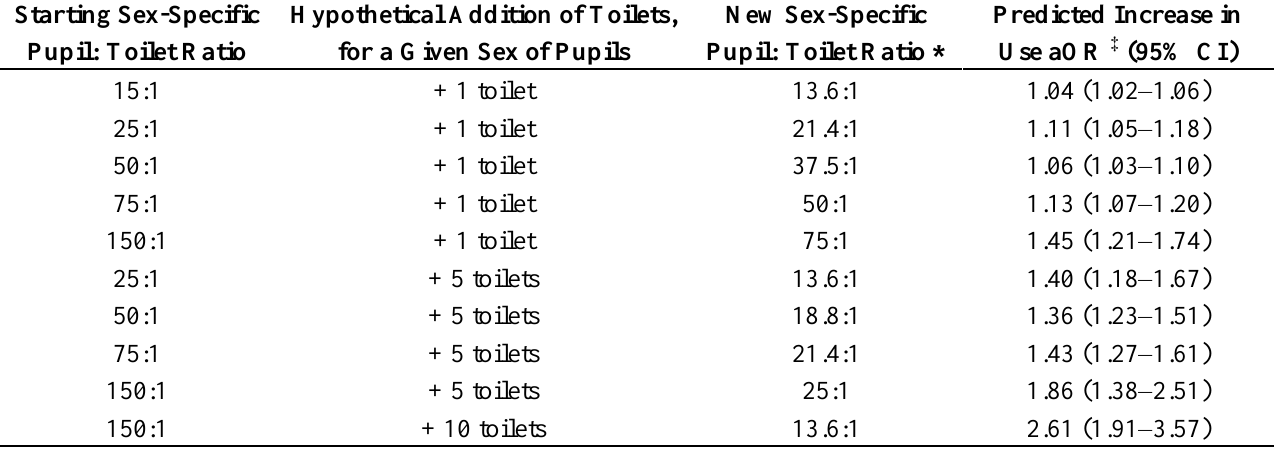
Table 3. Contrast of adjusted odds ratio for school toilet use and school pupil to toilet ratio, given additional toilets added to a